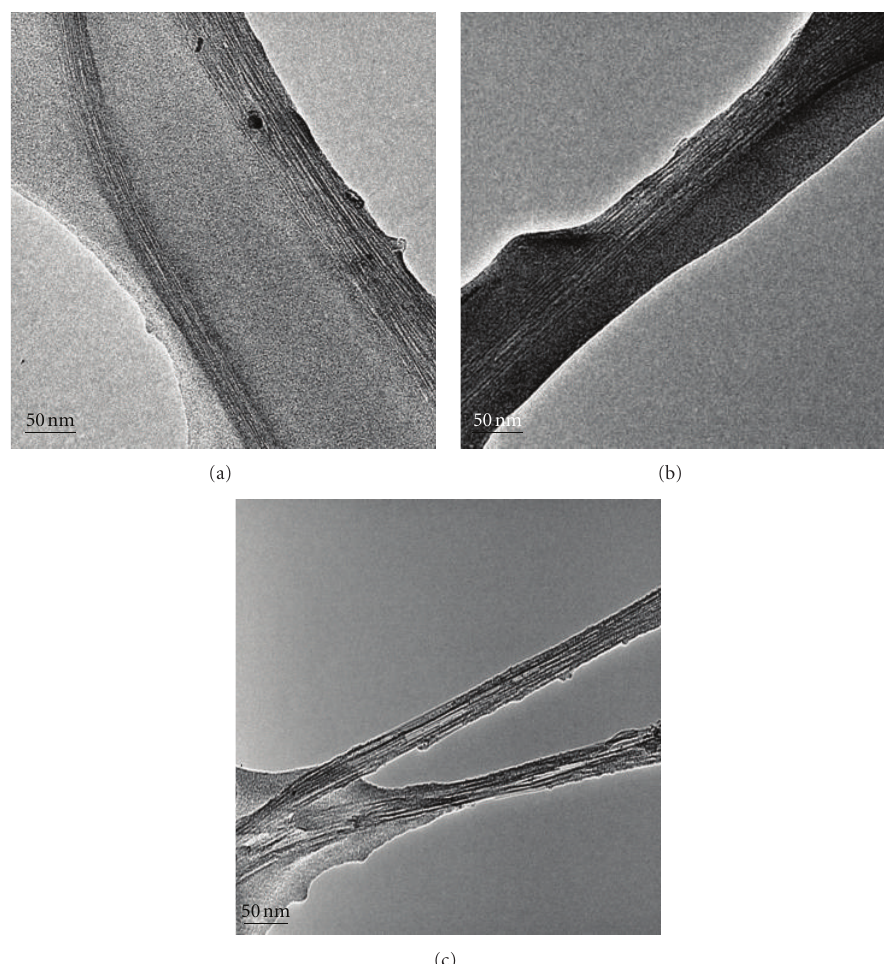
Figure 2: TEM micrographs of selected zein-SWNT composite nanofibers (Scale Bar: 50 nm).